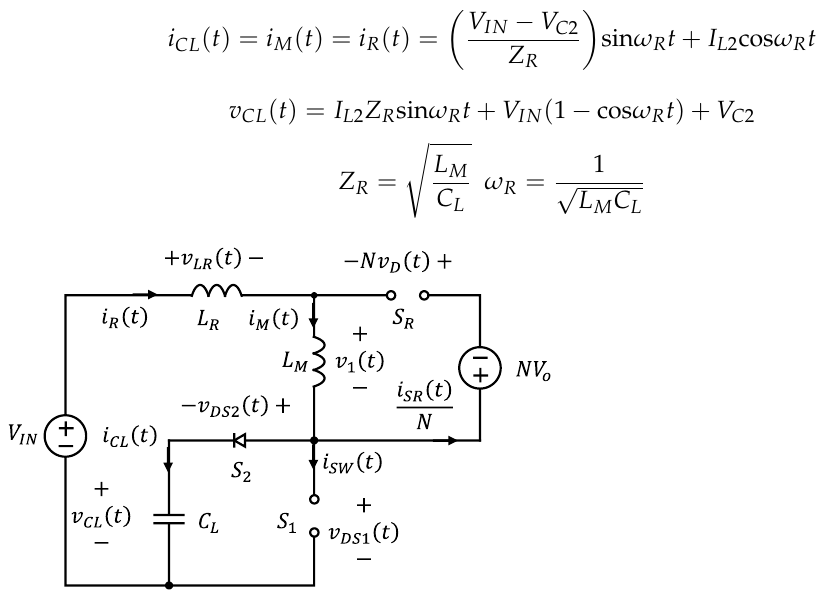
Figure 7. Equivalent circuit in state 2.